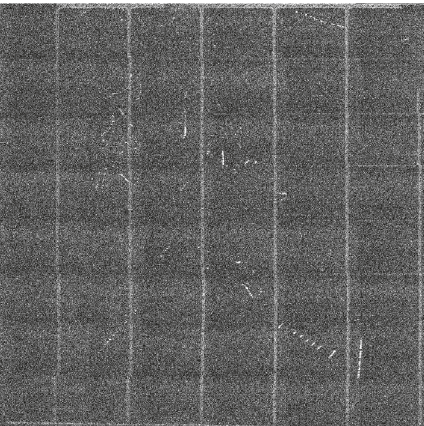
Figure 1: EL image of a large area fragment of structure under study obtained at 10V reverse bias. The distance between contact strips is 2.3